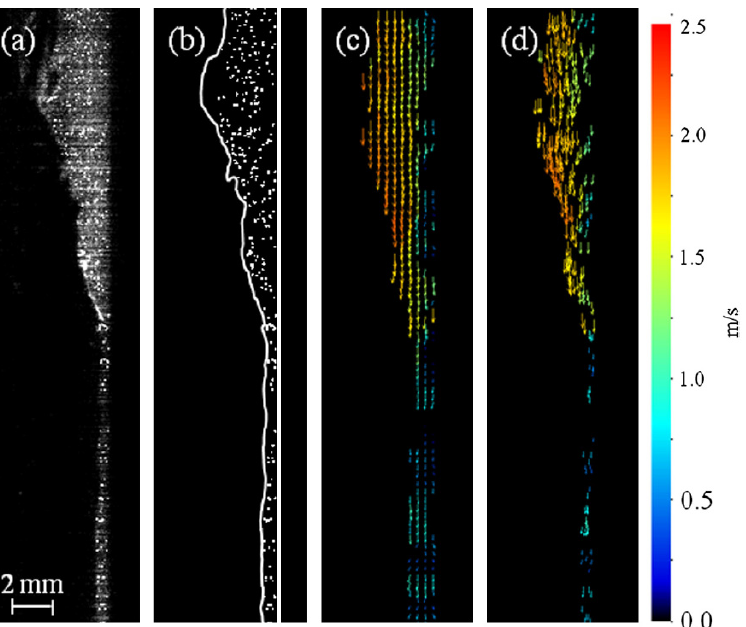
Figure 3. ( a ). A typical raw PIV image; ( b ), a processed raw image; ( c ), a velocity vector field and ( d ), a PTV velocity vector field